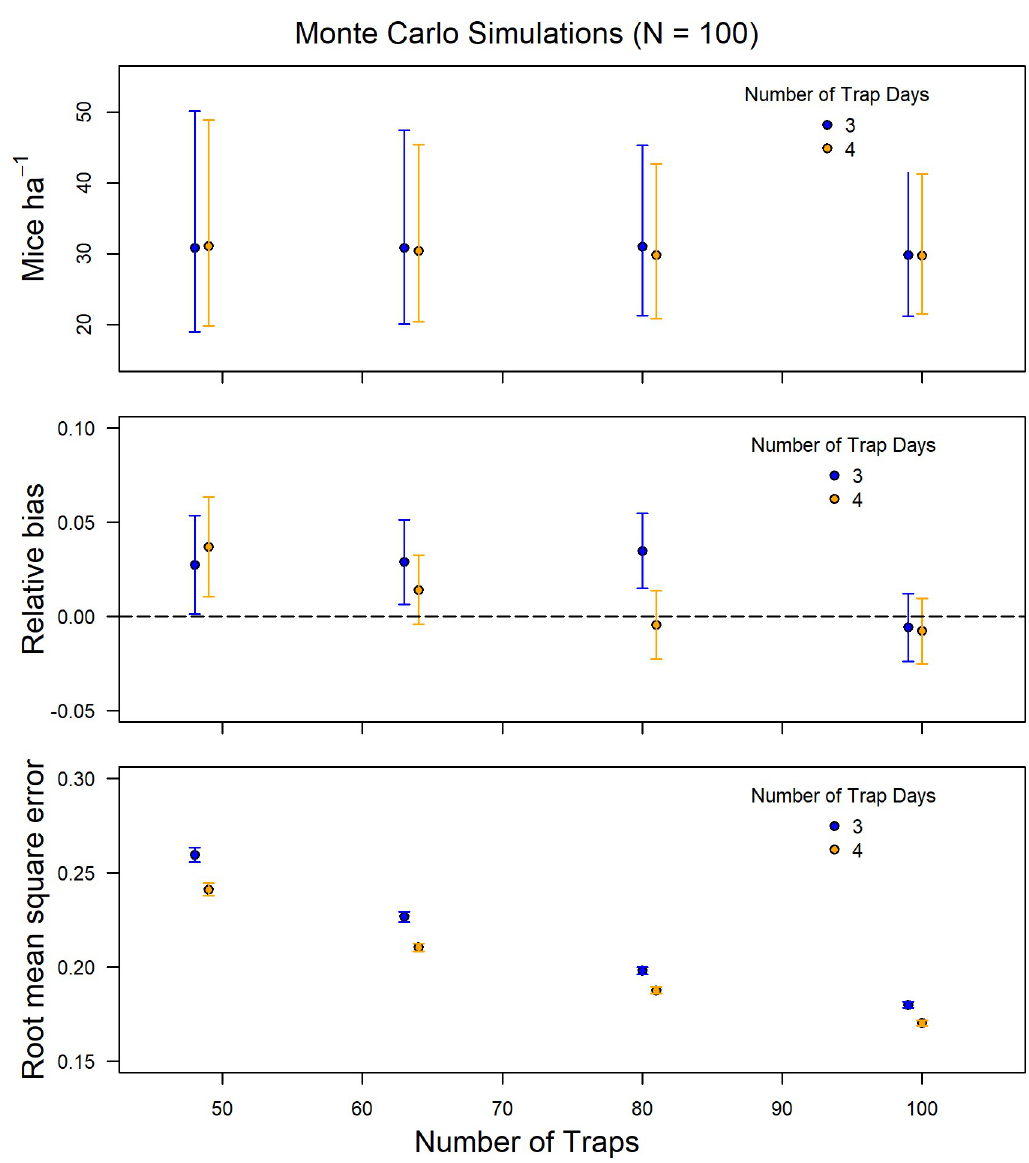
Fig 5. Density estimate, relative bias, and root mean square error for Monte Carlo simulations (n = 100) using the mean density, detection function, and home range as the true values for comparing the number of trapping occasions (3, 4), and the number of traps (100, 81, 64,